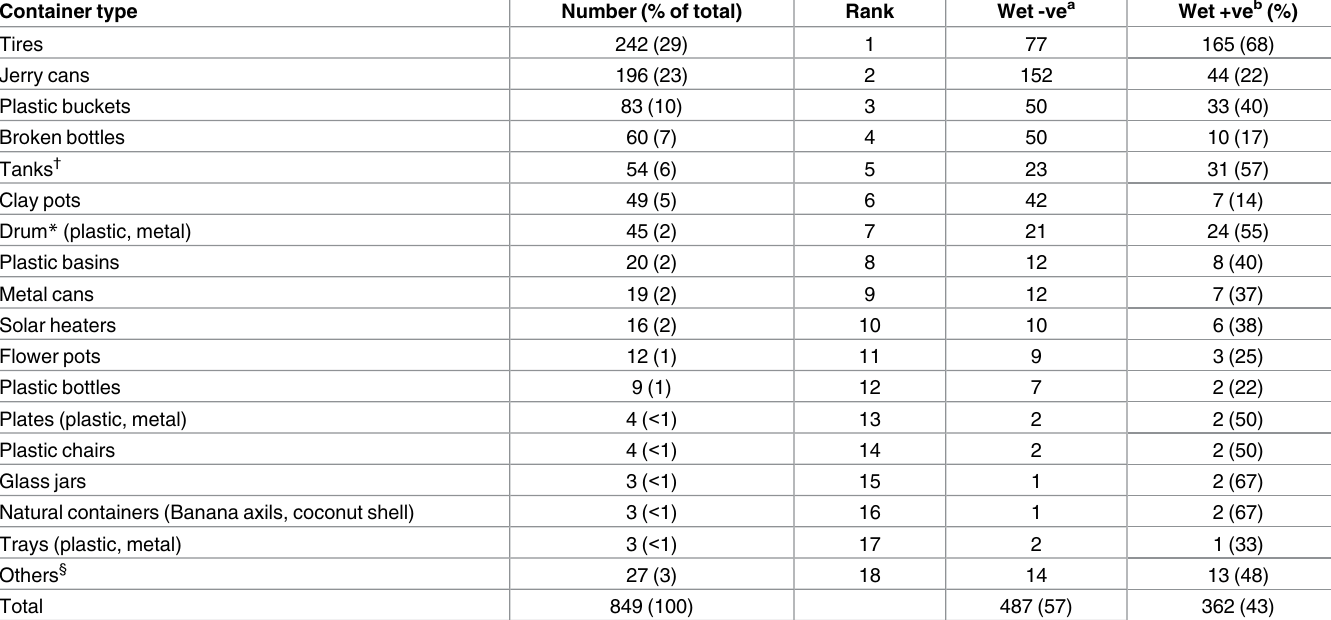
Table 2. Rank distribution of wet containers sampled outdoors and immature Ae . aegypti positivity by container type in Mombasa city during the